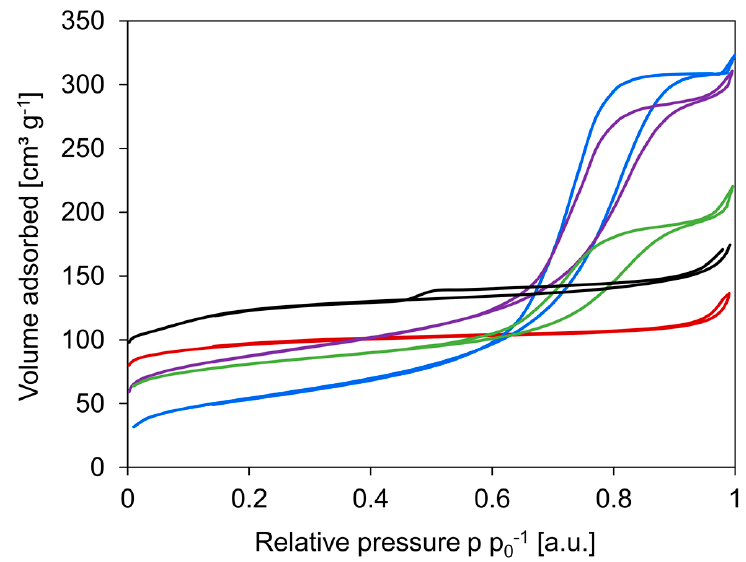
Figure 2. Nitrogen sorption isotherms for c-HZSM-5 (black), n-HZSM-5 (red), γ -Al 2 O 3 (blue), PM-50/50 (purple), and Hybrid-50/50 (green).